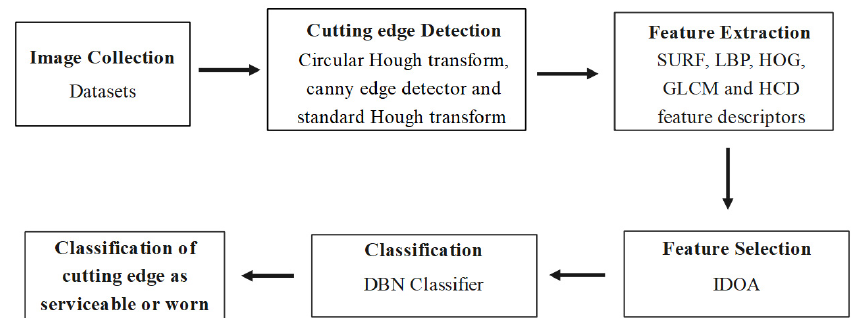
Figure 1. Workflow of the IDOA-DBN model.